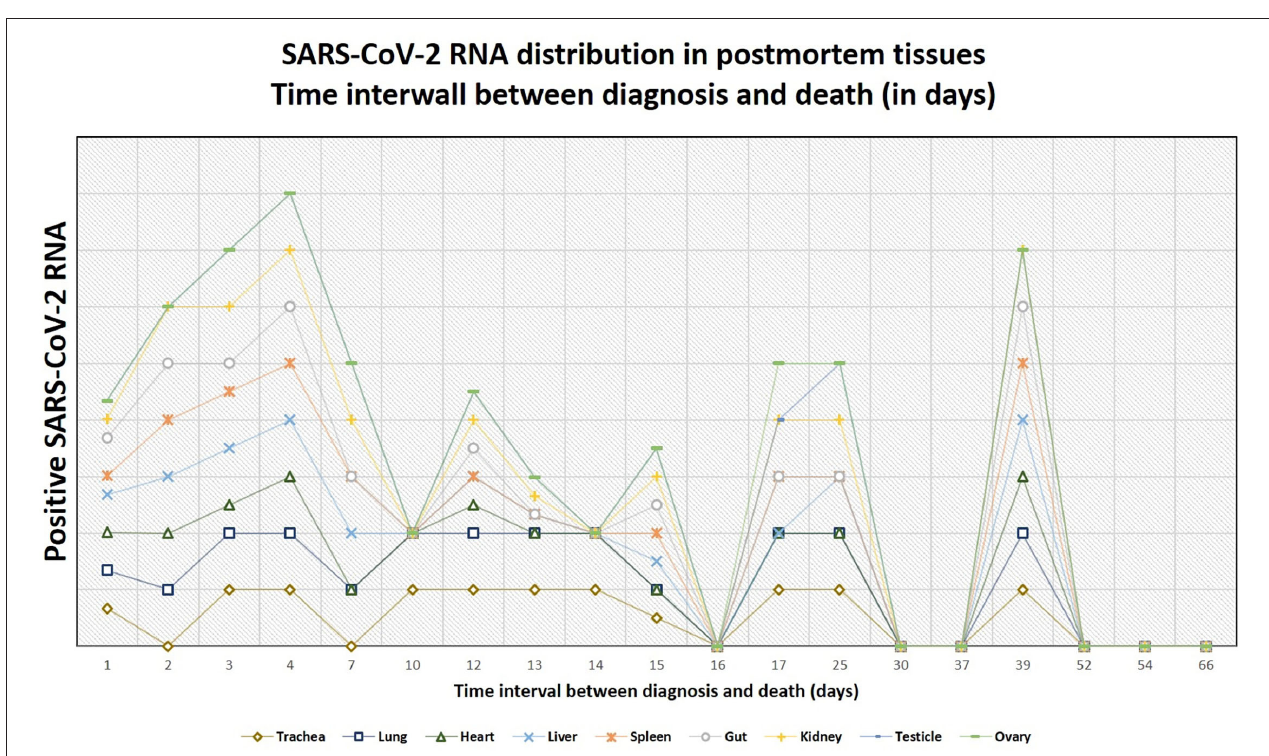
FIGURE 8 | The tendency of positivity of swabs for severe acute respiratory syndrome coronavirus 2 (SARS-CoV-2) RNA in relation to the time interval between diagnosis and death (in days). The lines do not show absolute percentages but only the relative variation in prevalence of the positivity for SARS-CoV-2 RNA. The different levels of the line along the y-axis are selected to avoid their overlapping and to facilitate the visual interpretation but do not reflect an absolute percentage, for which we refer the reader to the text.